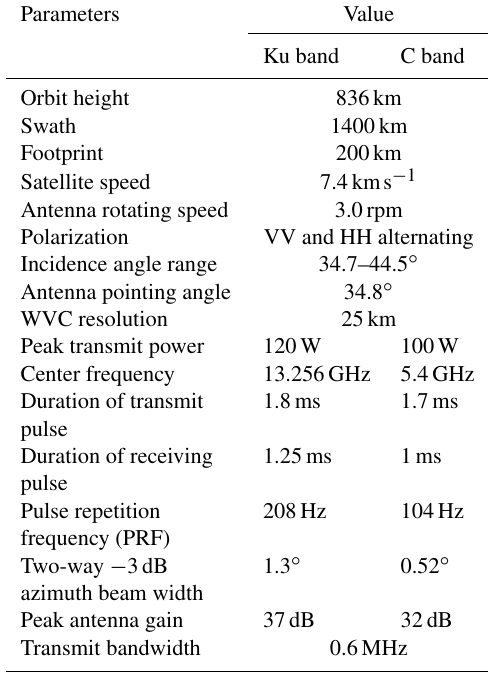
Table 2. Main parameters of FY-3E